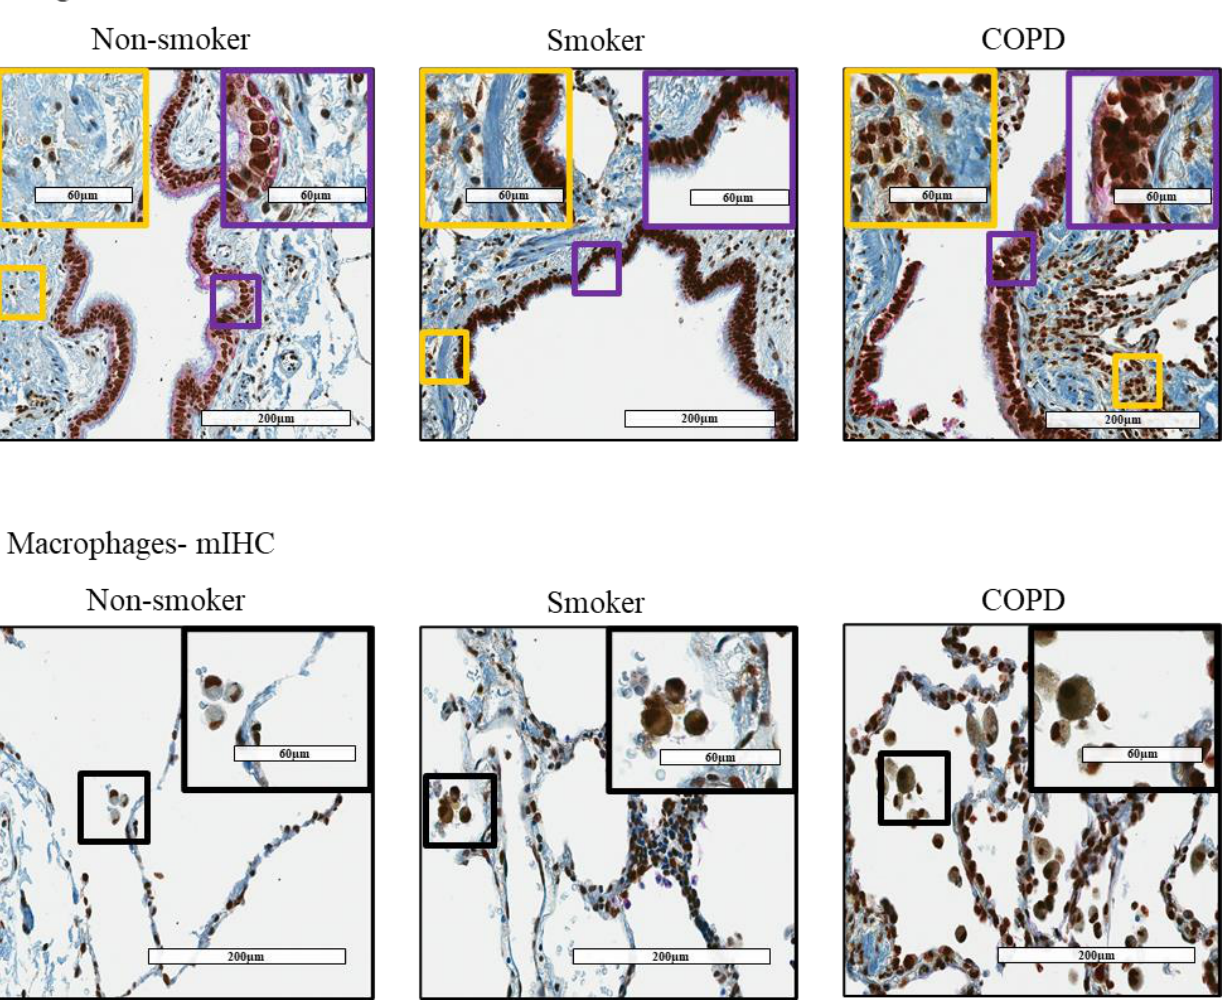
Figure 4. Cytoplasmic expression of HuR increased in lung tissue and macrophages from smoker and COPD subjects . ( A ) Lung tissue — mIHC: lung tissue was stained with mIHC: HuR was stained with brown color, Cytokeratin 19 expression (a marker of epithelial cells) was stained with purple color, and vimentin (a marker for fibroblasts) was stained yellow. There was more HuR in the cytoplasm of epithelial cells and fibroblasts from smoker and COPD subjects comparing to these cells from non-smoker individuals. ( B ) Macrophages — mIHC: there was an increase in cytoplasmic HuR in macrophages from smoker and COPD subjects. The pictures were taken by Aperio ImageScope with 20×, and 40× for higher magnification. Images are representative for 3 to 4 subjects/group.